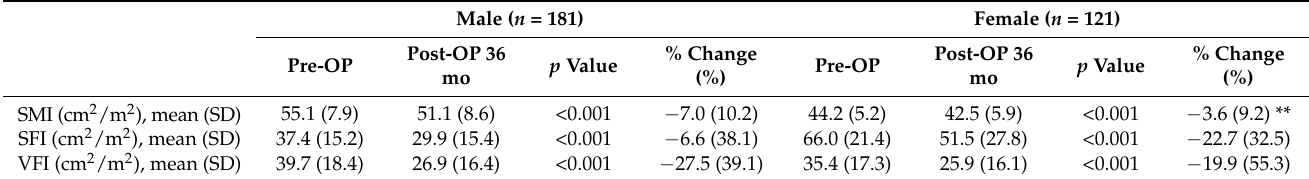
Table 2. Changes in body composition during the survival period.